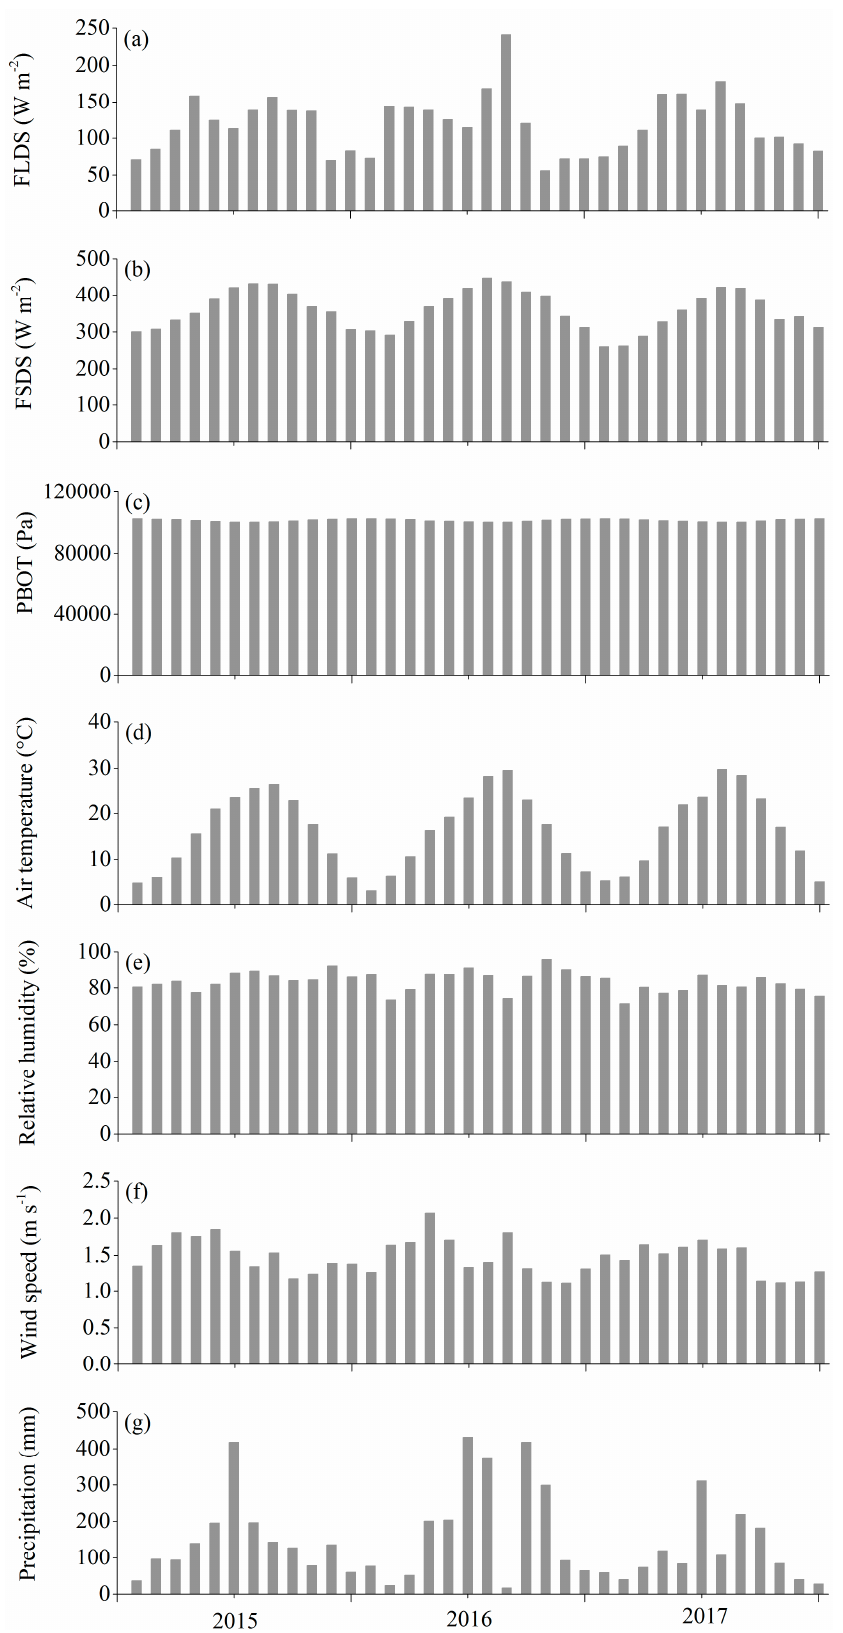
Figure 3. Meteorological data used to drive the model. ( a ) FSDS, incident solar radiation; ( b ) FLDS, incident longwave radiation; ( c ) PBOT, atmospheric pressure; ( d ) air temperature; ( e ) wind speed, and ( f ) precipitation.